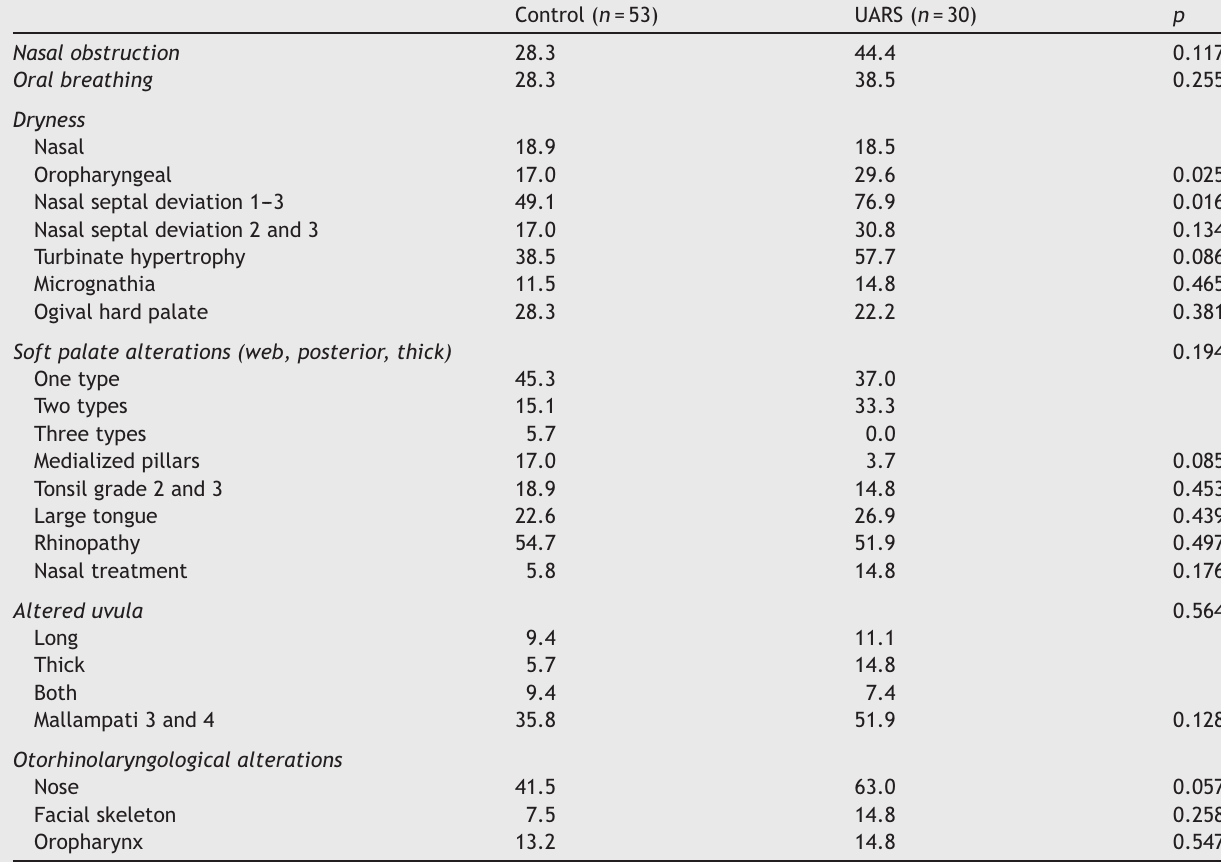
Frequency (%) of volunteers in the control and UARS groups, according to the systematic physical examination of the facial skeleton, nose, mouth, and pharynx.